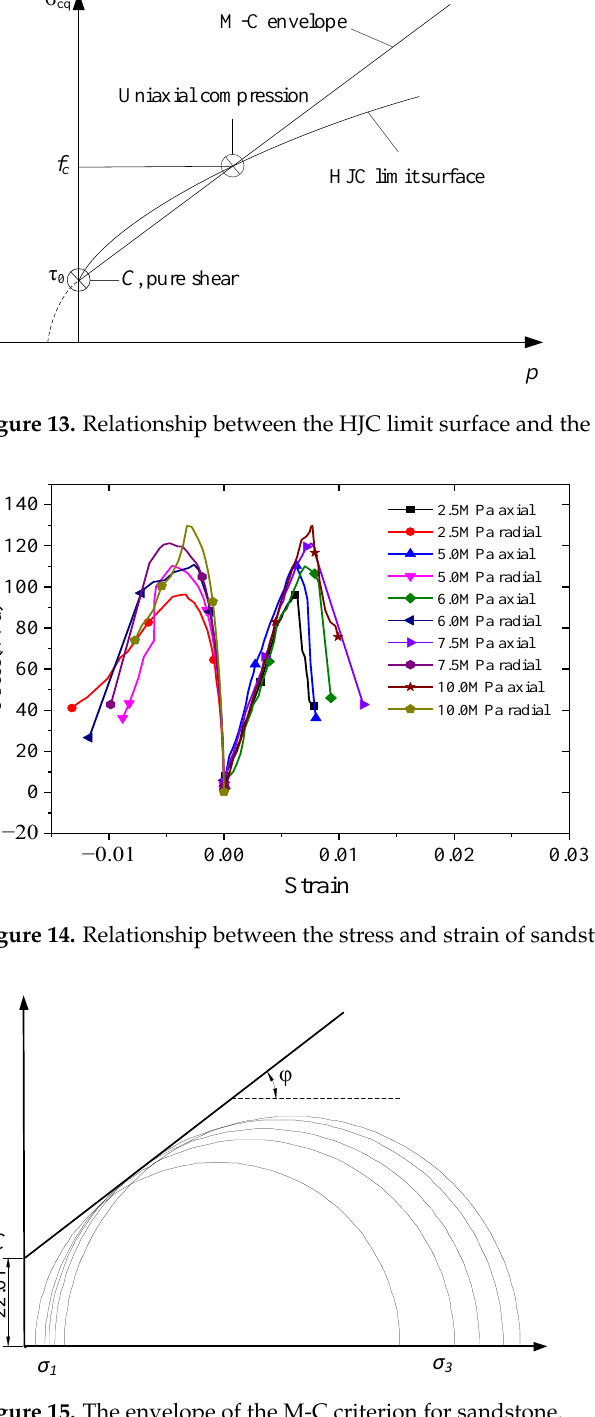
Figure 15. The envelope of the M-C criterion for sandstone.